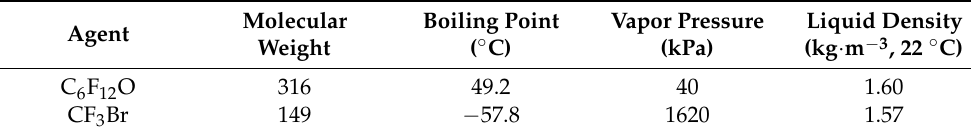
Table 2. The typical parameters of C 6 F 12 O and CF 3 Br